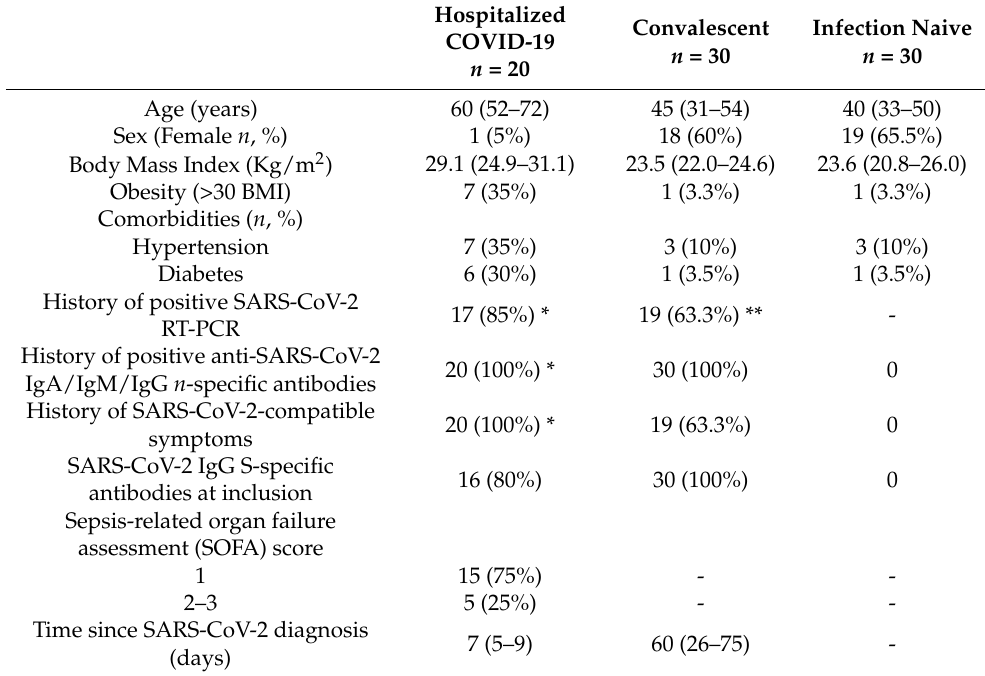
Table 1. Characteristics of study’s participants at